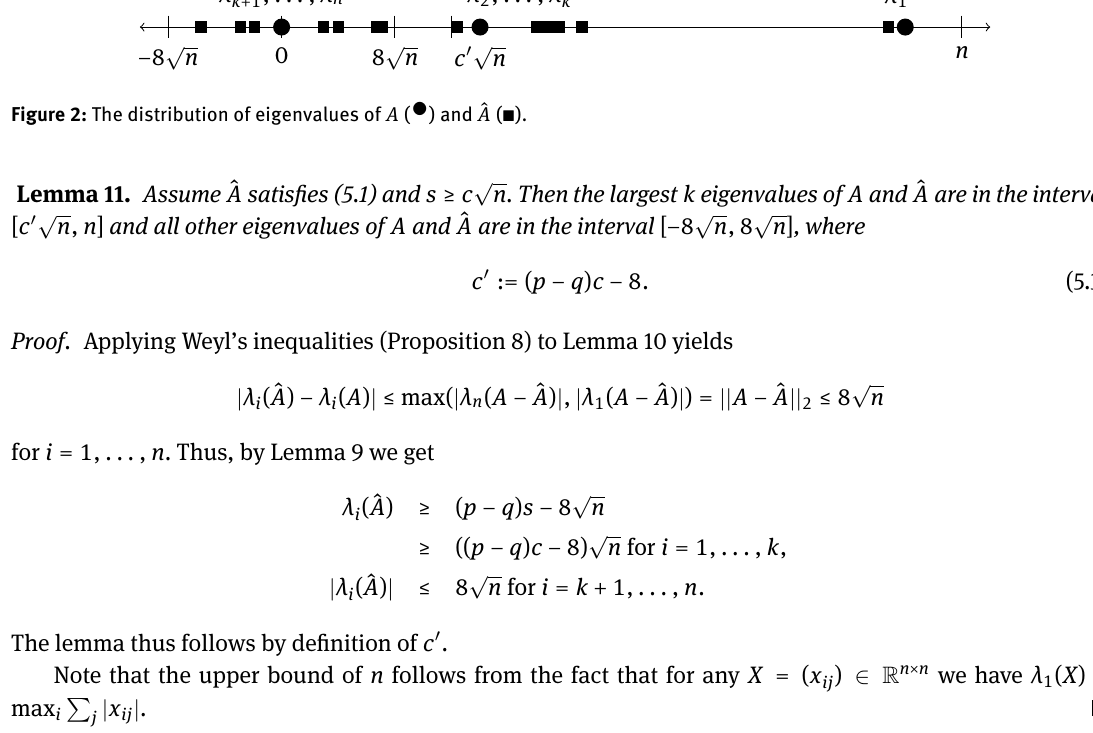
Figure 2: The distribution of eigenvalues of A (